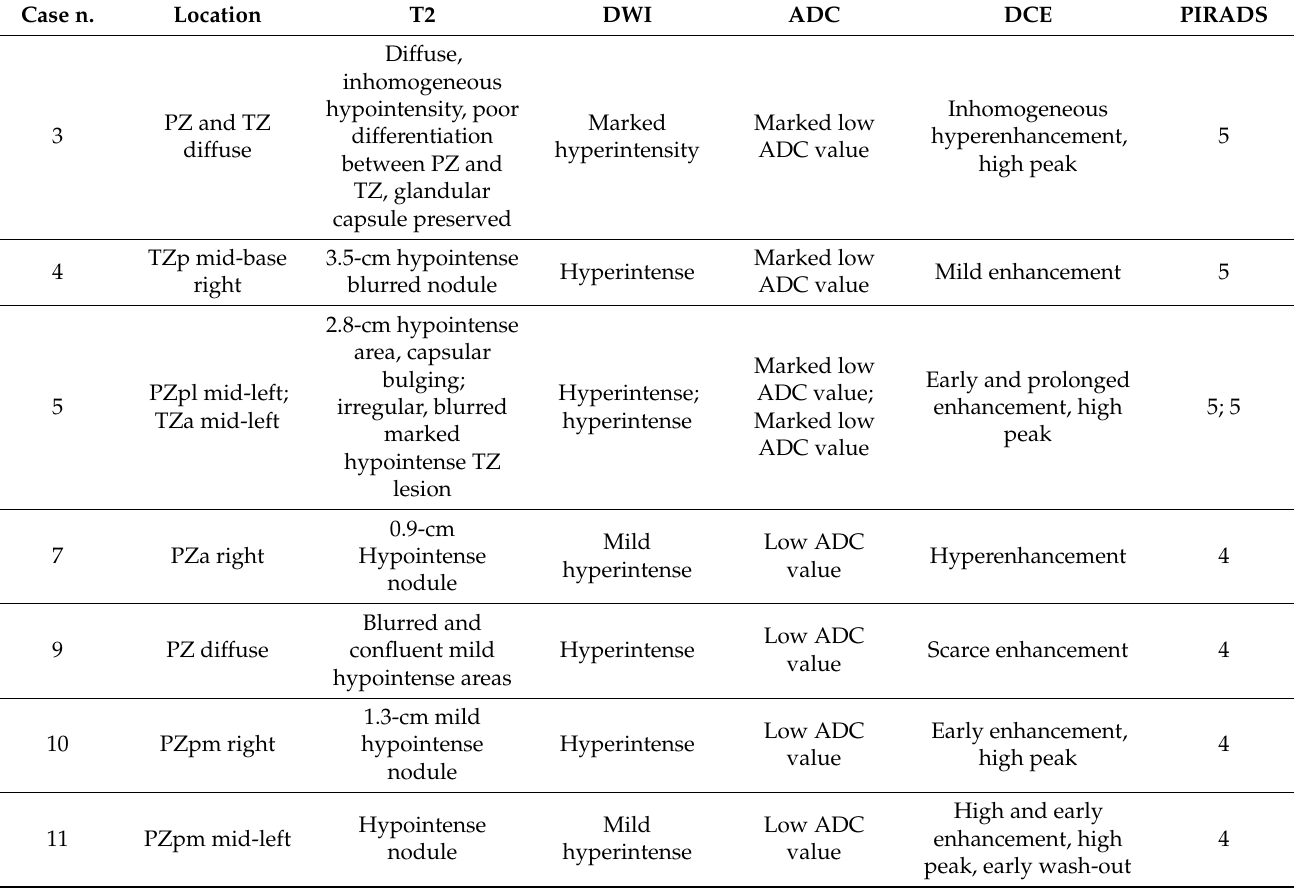
Table 3. mpMRI imaging features in BCG-GP